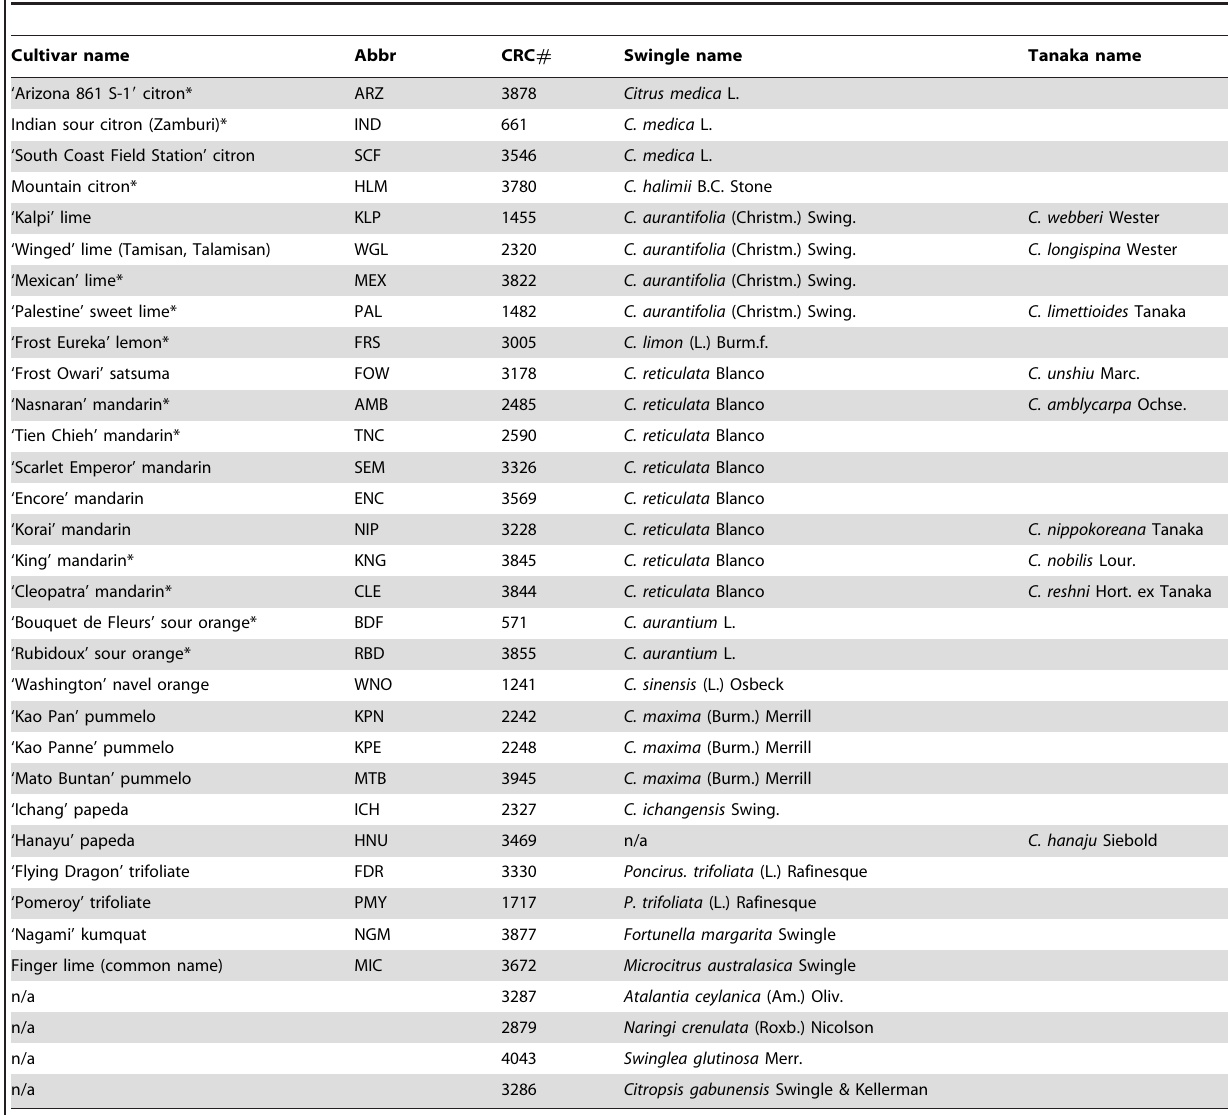
Table 1. Study taxa and voucher information.